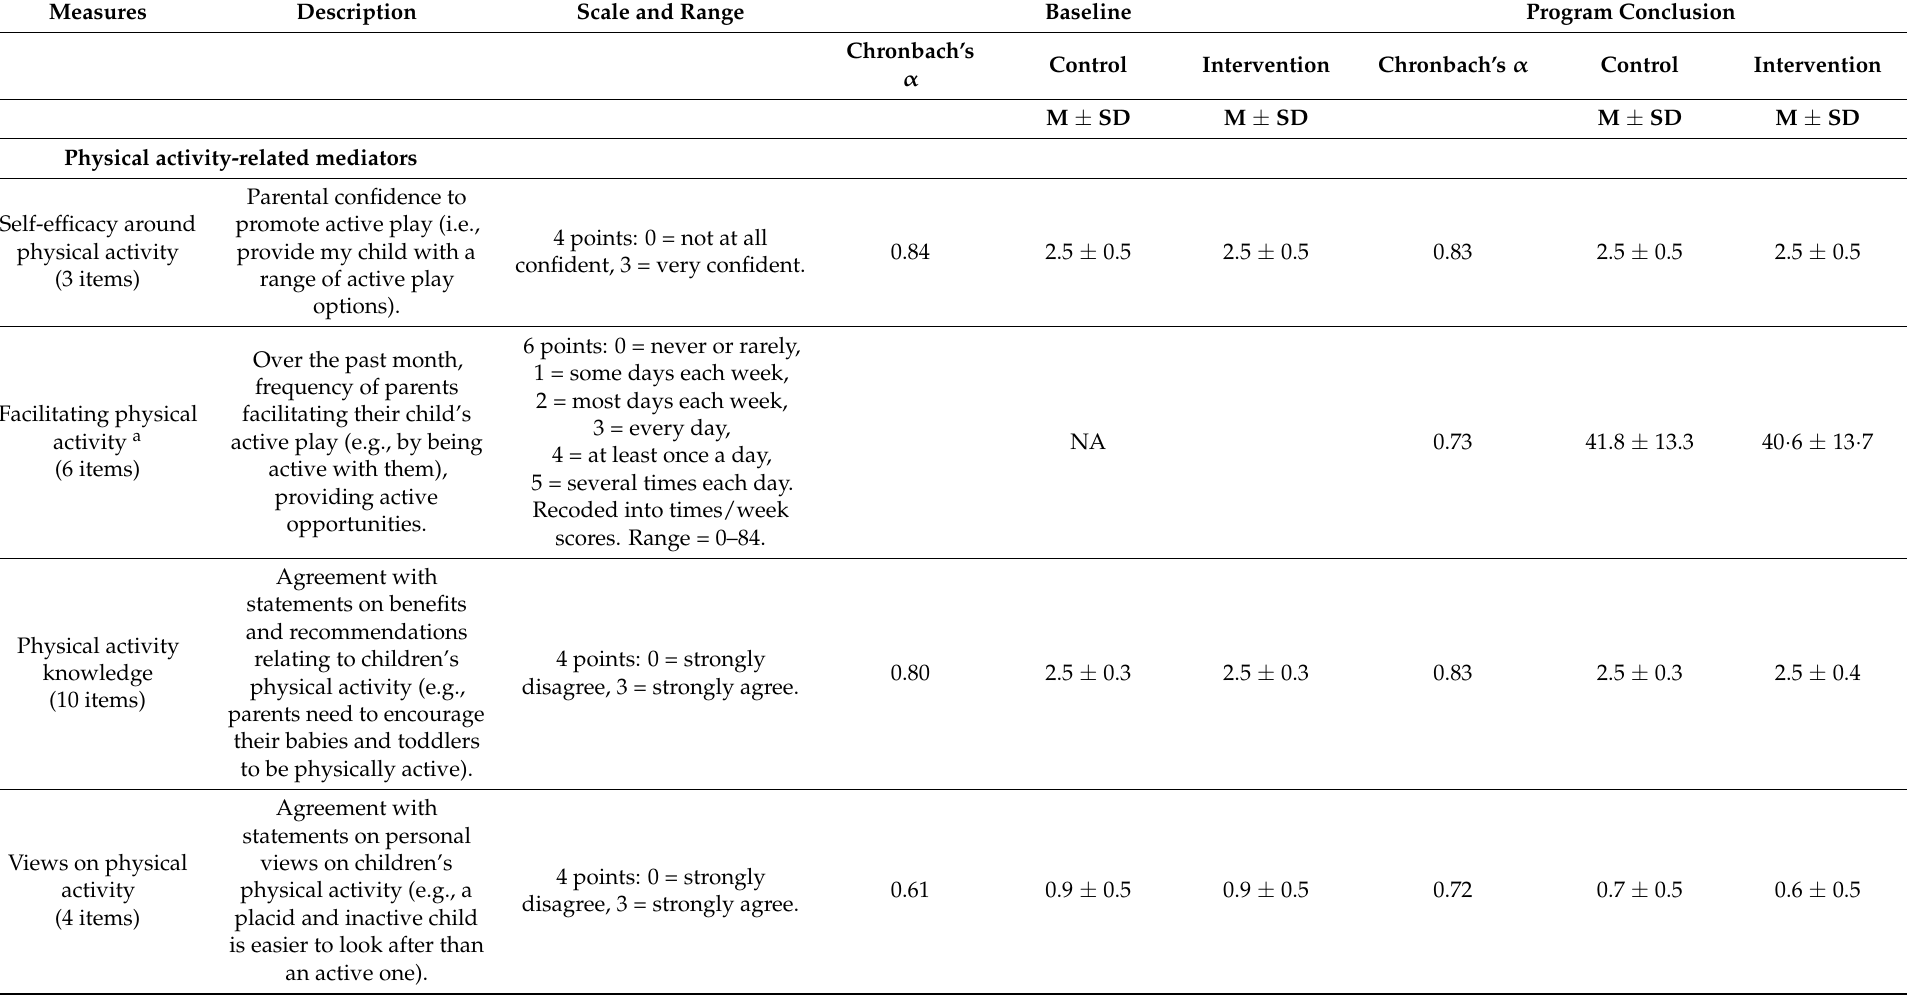
Table 1. Descriptions of potential mediator